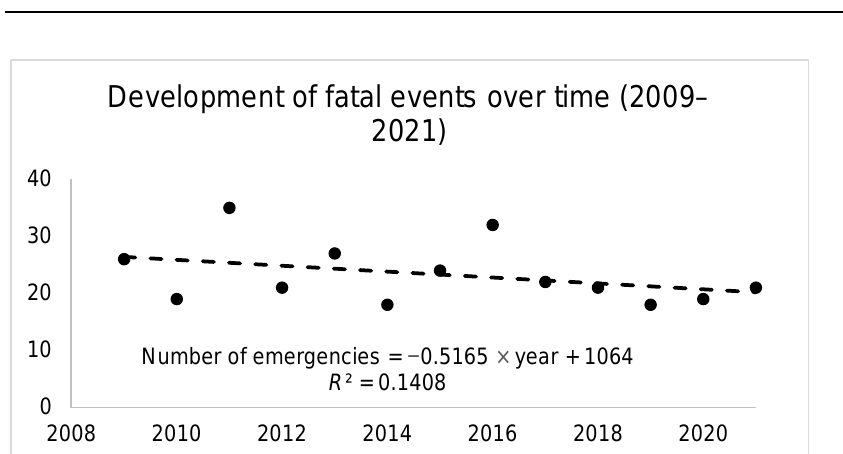
Number of emergencies = − 0.5165 × year + 1064 R ² = 0.1408